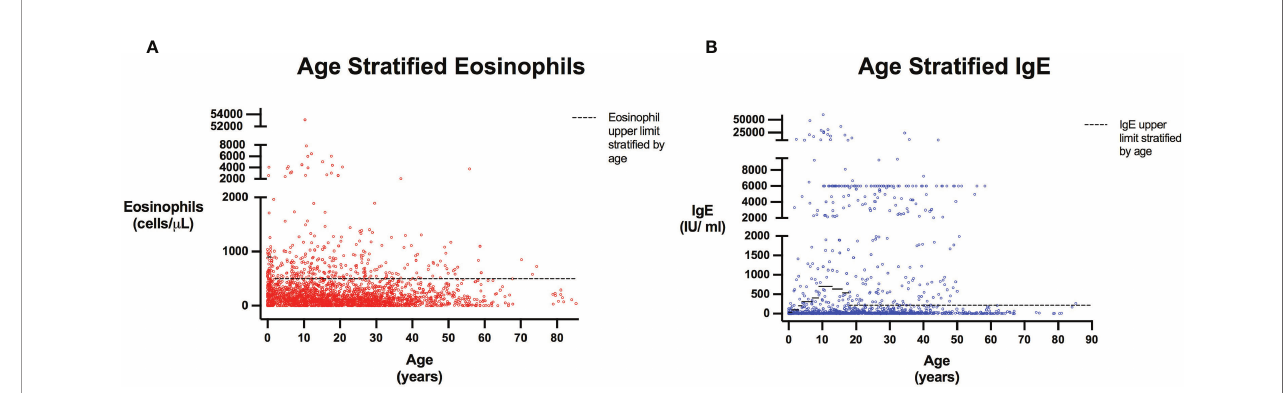
FIGURE 2 | Eosinophils and IgE strati fi ed by age. Scatter plots show all patients included in the analysis with every reported Eosinophil (A) or IgE (B) value. Patient age was calculated as the time interval between their laboratory date and June 15 th of their birth year, as birth month and date were not provided for patient con fi dentiality and anonymity. Dashed line represents Eosinophil and IgE upper limits strati fi ed by age based on reference populations (22, 23). Eosinophil upper limits correspond to 900 cells/ m L in those <1 years, and 500 cells/ m L for those 1 years of age and older (with values for individuals aged greater than 21 extrapolated to be 500 cells/ m L). IgE level upper limits are: 6 to 12 months, 34 IU/ml; 1 to 2 years, 97 IU/ml; 3 years, 199 IU/ml; 4 to 6 years, 307 IU/ml; 7 to 8 years, 403 IU/ml; 9 to 12 years, 696 IU/ml; 13 to 15 years, 629 IU/ml; 16 to 17 years; 537 IU/ml; 18 years and older, 214 IU/ml (23). For individuals less than 6 months of age, the IgE level upper limit was extrapolated as 34 IU/ml.